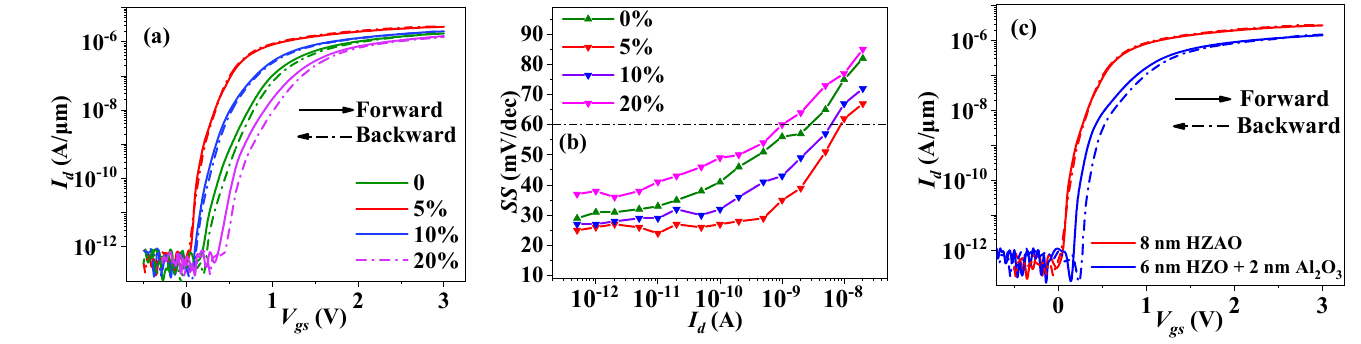
The drain current vs. gate-source voltage ( I d -V gs ) curves of the transistors were measured using a Keithley 4200 SCS semiconductor parameter analyzer in a light-tight and electrically-shielded probe station in an atmospheric pressure environment at room Figure 2. ( a ) P-E curves of HZAO thin films with different Al contents; ( b ) C-V curves of temperature, as shown in Figure 3a. The sweeping range of V gs was from − 1 V to 3 V, with (Au/Cr)/HZAO/p ++ -Si capacitors with different Al contents at 5 kHz (annealing temperature: 650 a sweeping rate of 0.2 V/s and drain-source voltage ( V ds ) fixed at 50 mV. The SS-I d relations °C); ( c ) C-V curves of (Au/Cr)/HZO/p ++ -Si and (Au/Cr)/HfO 2 /p ++ -Si and capacitors at 5 kHz (anneal- ing temperature: 650 °C). were extracted from the transfer curves and are shown in Figure 3b.